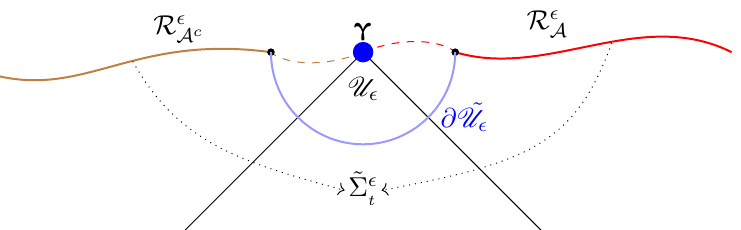
Figure 7. The local geometry near the cosmic brane and the boundary conditions in Lorentz signature. We have exhibited here the regulated ket spacetime M k by excising a topological half-disc ribbon around the fixed point locus g (i.e., half of the exicison domain U (cid:15)